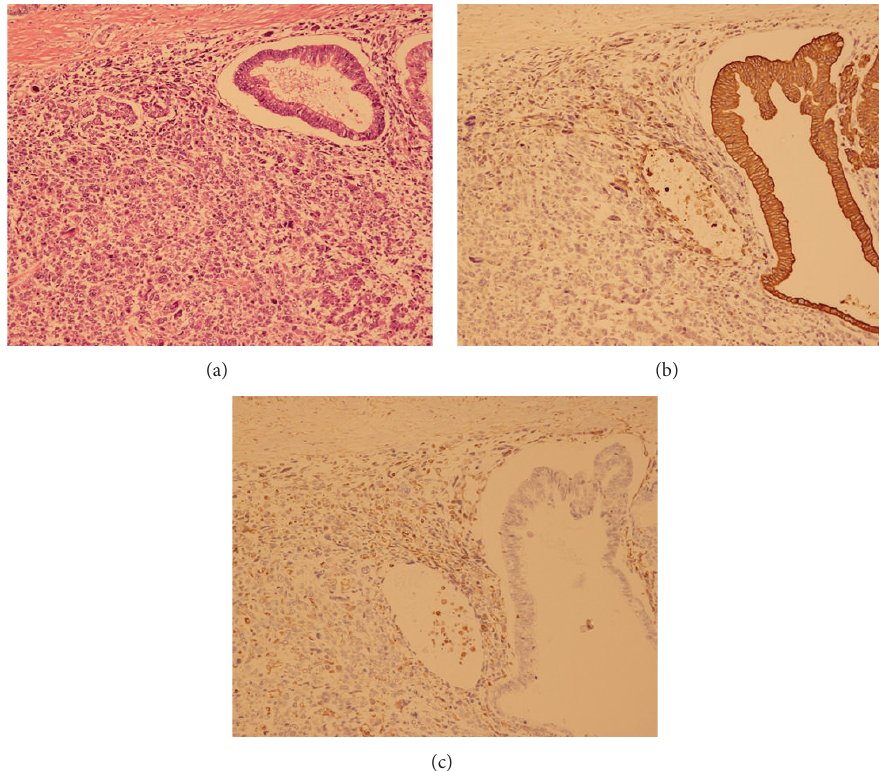
Figure 4: (a) Histologic assessment of the tumor showing the presence of an epithelial component and a nonepithelial sarcomatoid component. The epithelial component showed glandular differentiation, while the sarcomatoid component revealed a complicated growth of spindle-like and oval cells with a pleomorphic and bizarre configuration of the nuclei showing mitosis (HE). (b) Immunohistochemical assays showing that the sarcomatoid component was moderately reactive to antibody against pancytokeratin. (c) The sarcomatoid component was strongly reactive to antibody against